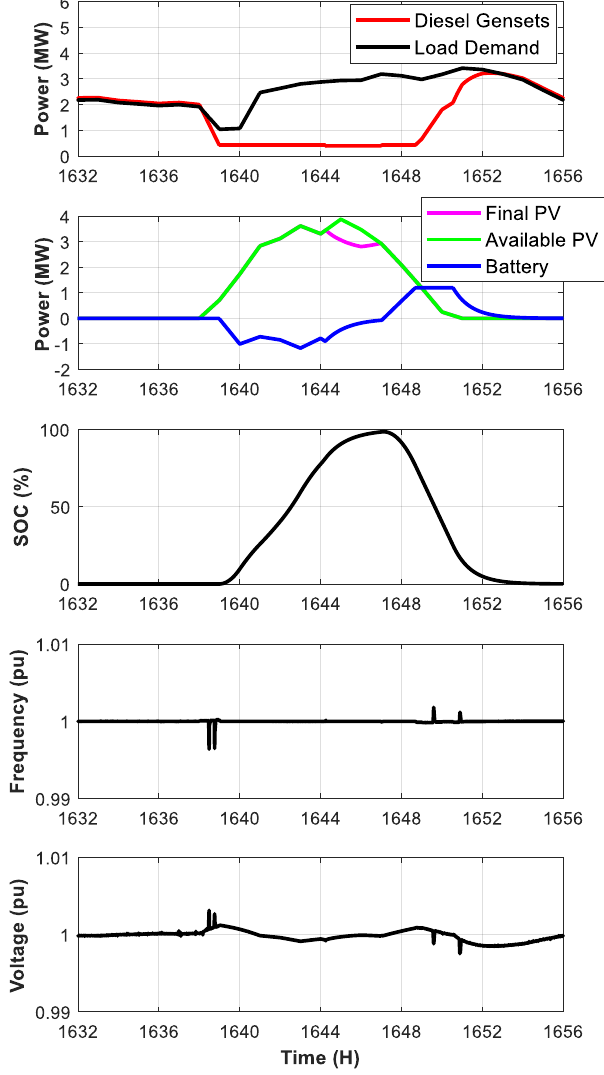
Figure 5. Microgrid operation for one day in summer using the priority EMS Strategy.